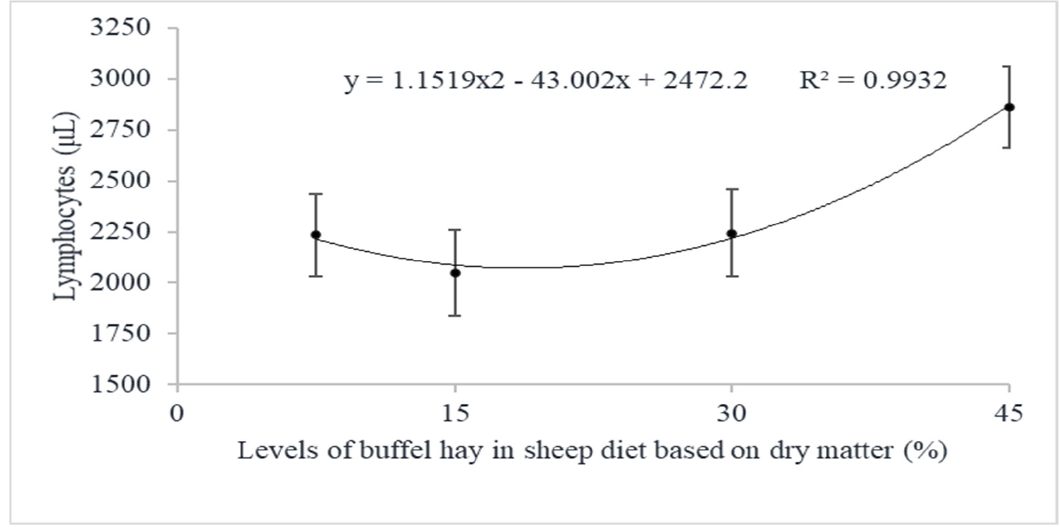
Figure 3. Effect of levels of buffel grass hay on lymphocytes.